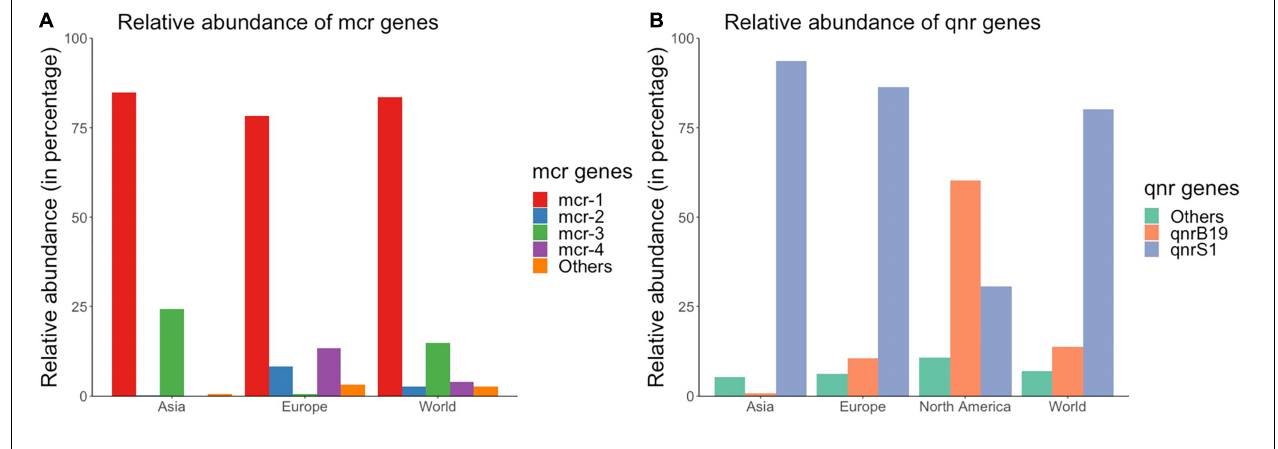
TABLE 2 | Top five sequence type (ST), ST complexes, serotypes, phylotypes and fim H type of E. coli isolates carrying mcr, qnr, or chromosomal mutations in QRDRs (numbers in brackets represent the number of isolates carrying a particular genetic characteristic). ST ST complex Serotype Phylotype fimH Chromosomal mutations in